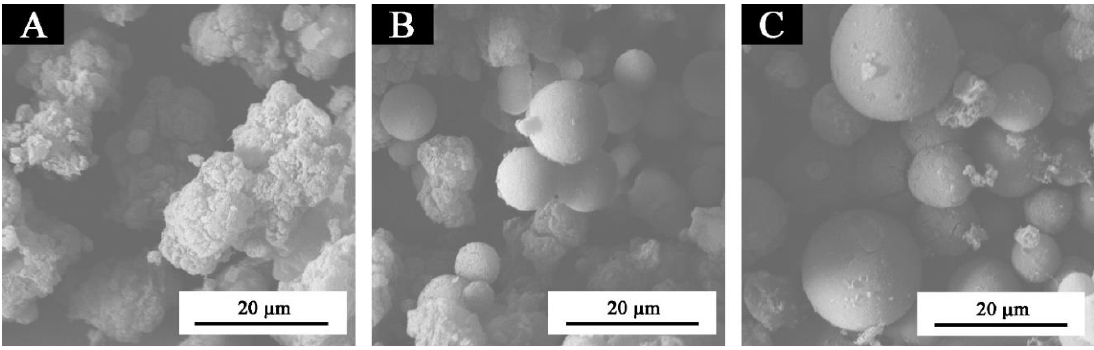
Figure 1. SEM of microcapsules with different core-wall ratios: ( A ) 0.42:1, ( B ) 0.67:1, ( C ) 0.75:1.